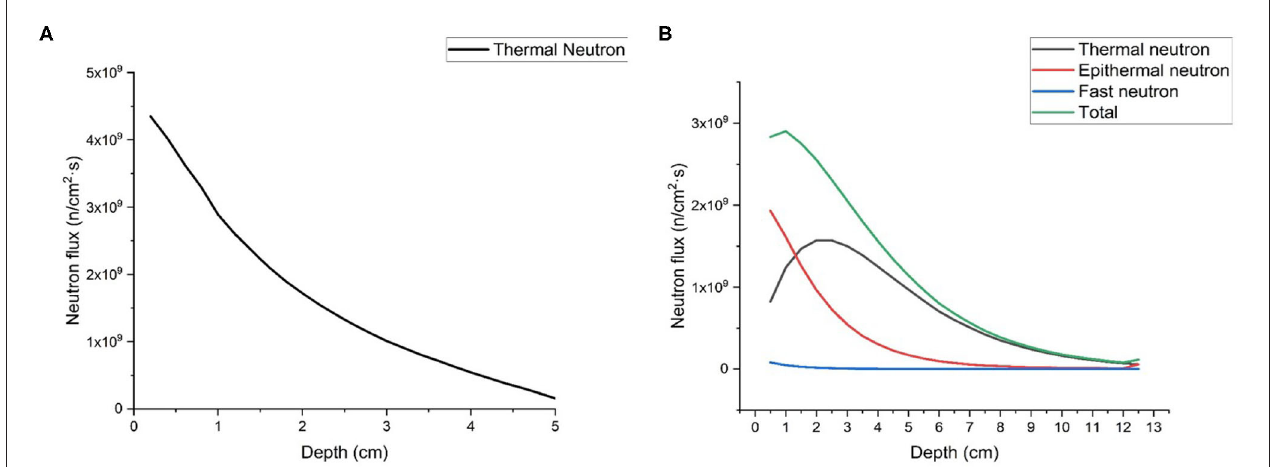
FIGURE 8 | Neutron flux distribution in the phantom, (A) is thermal neutron beam, and (B) is epithermal neutron beam.